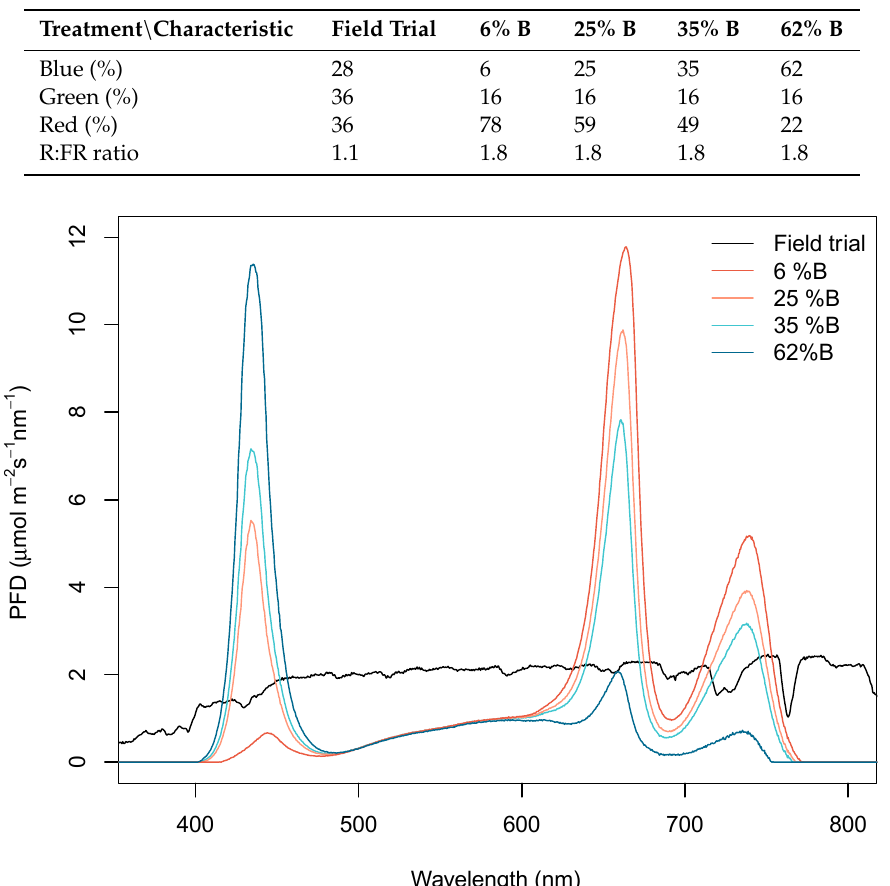
Figure 1. Applied spectra for the field trial and each of the di ff erent light treatment where 6%, 25%, 35% and 62% refers to the percentage of blue light as percentage of the photosynthetic photon flux density (PPFD) (In other words, excluding far-red). The integrated area between 400 and 700 nm corresponds to an approximate 575 μ mol m -2 s -1 of photosynthetic photon flux density in each case.